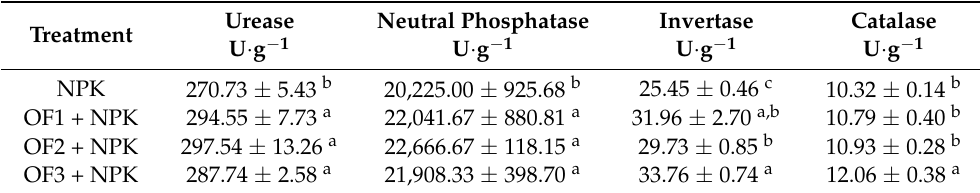
Table 4. Effects of organic–inorganic fertilizers on soil enzyme activity in a dry direct-seeded rice paddy